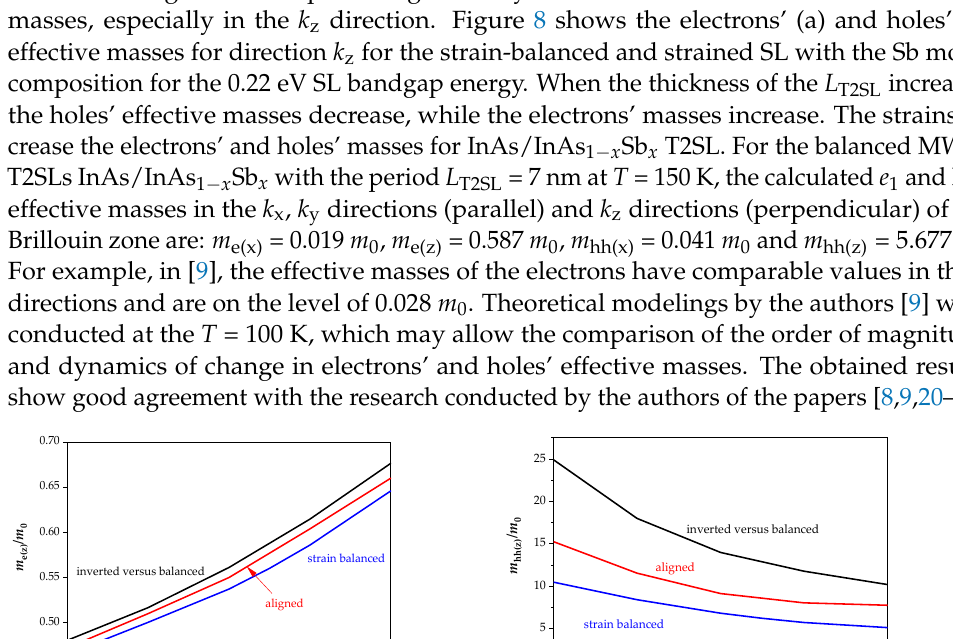
Figure 7. Theoretical simulation of the electrons’ ( a ) and holes’ ( b ) effective masses in the z-direction for the strain-balanced and strained SL versus of the Sb molar composition, x for the T2SL L T2SL = 4 nm layer thickness at 150 K.